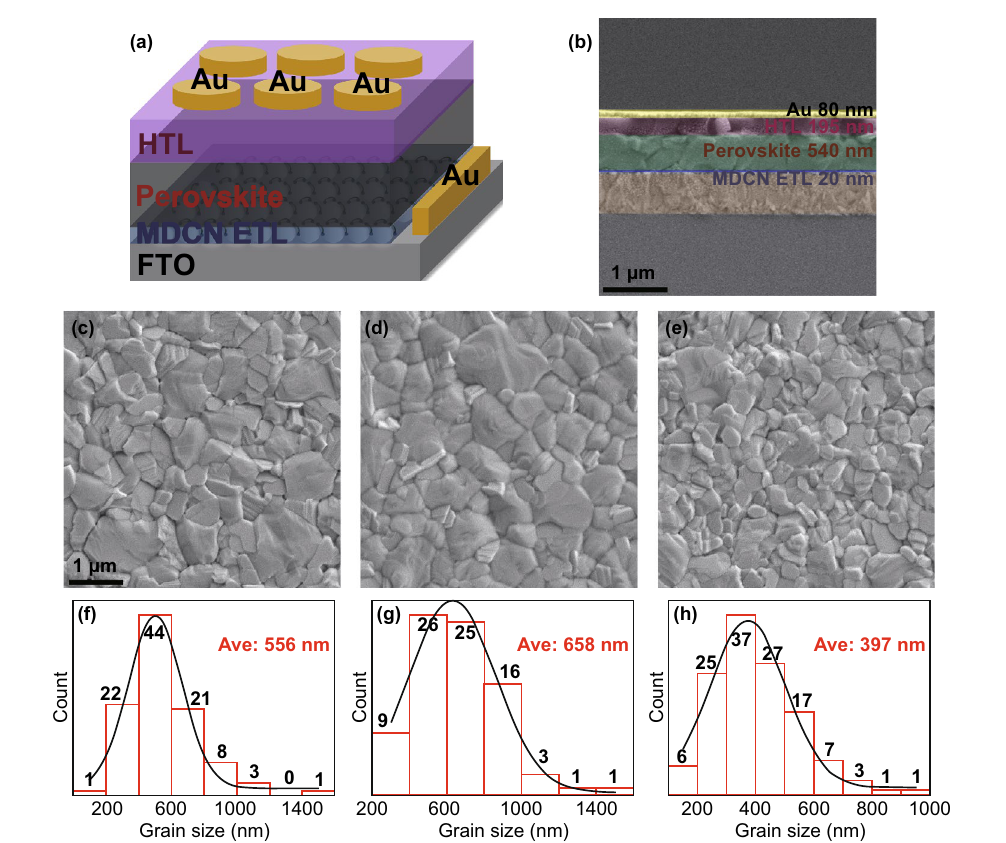
Fig. 6 a Device structure of a PSC using MDCN as ETL. b Cross‑sectional SEM image of a complete device with MDCN‑0.02 ETL. The SEM images of perovskite layers on the ETL of c MDCN‑Air, d MDCN‑Air&N 2 , e MDCN‑N 2 . F – h Statistic grain size distributions for perovskite film in c – e ,